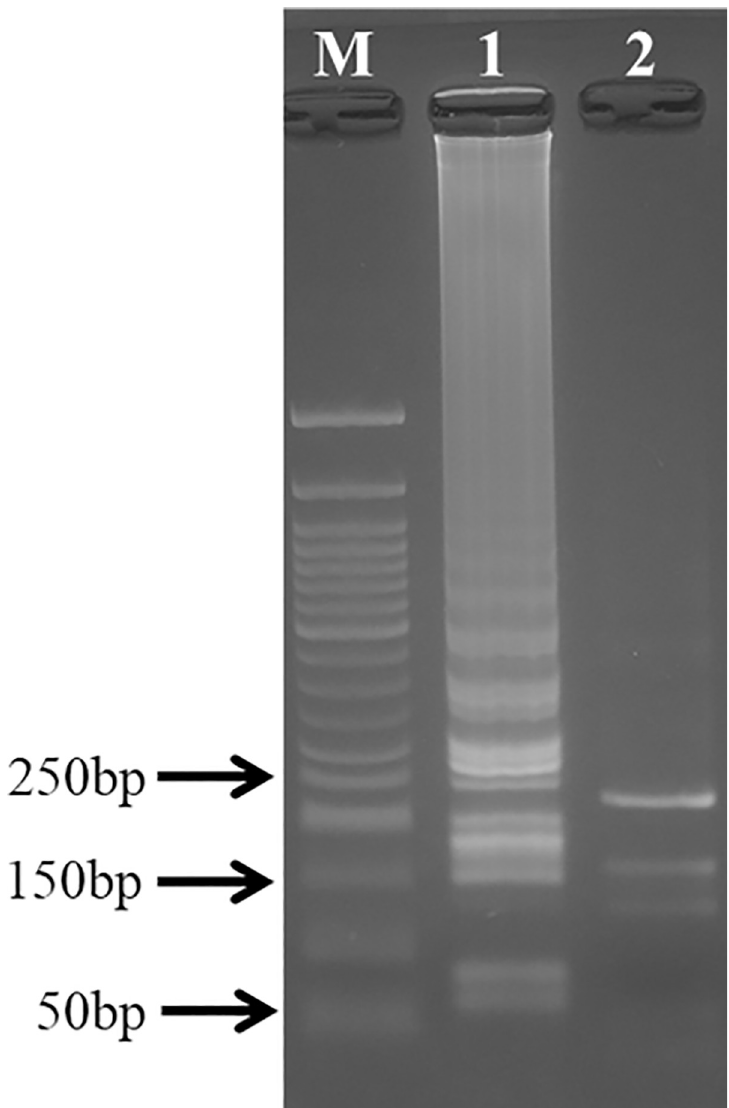
Fig 3. Enzymatic digestion of target sequence by restriction enzyme Eco RI. Lane M, 50bp DNA maker (New England Biolabs). Lane 1, LAMP products without the restriction enzyme. Lane 2, LAMP products digested by Eco RI. The predicted product sizes were 124bp, 169bp and